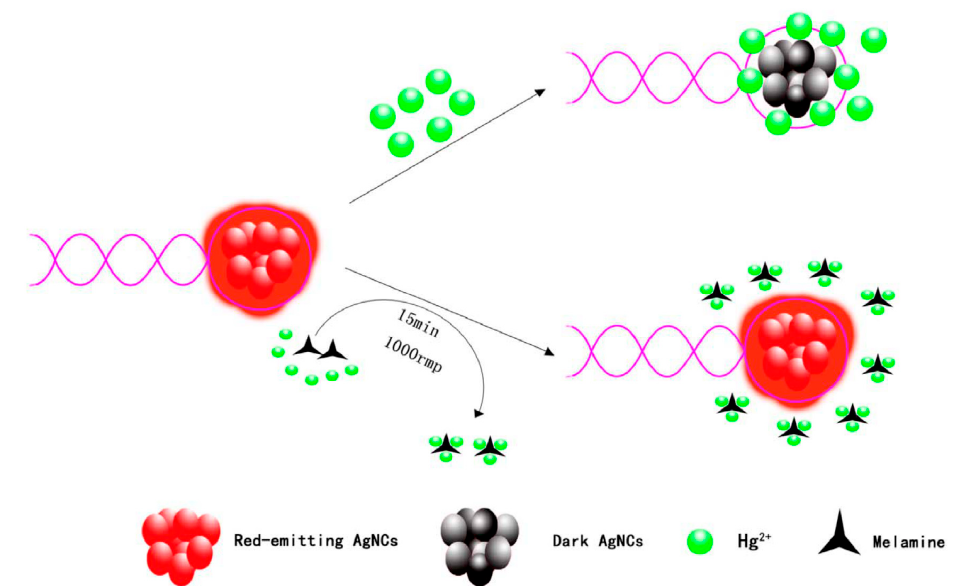
Figure 7. A fl uorescence turn-on strategy for detecting melamine based on the coordination between melamine and Hg 2+ (reproduced with permission from Reference melamine and Hg 2+ (reproduced with permission from Reference [58]).